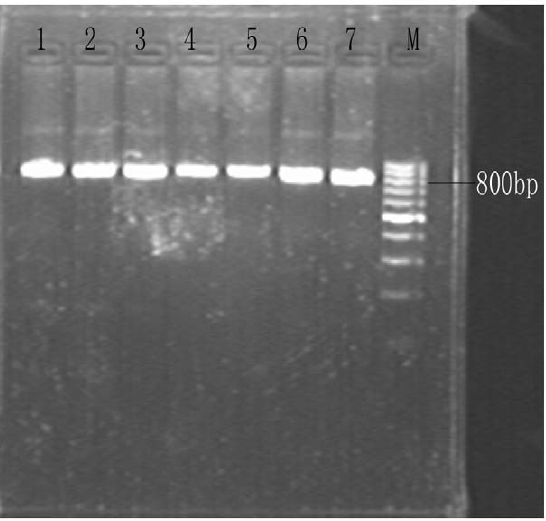
Figure 2. Agarose gel electrophoresis of Shaoxing sequences. PCR amplification products of respective Cryptosporidium isolates were subjected to 2% agarose gel electrophoresis. Lanes 1–6 represent secondary 18S rRNA amplification products, lane 7 positive control and M, 100 bp DNA ladder. PCR products are approximately 840 bp.